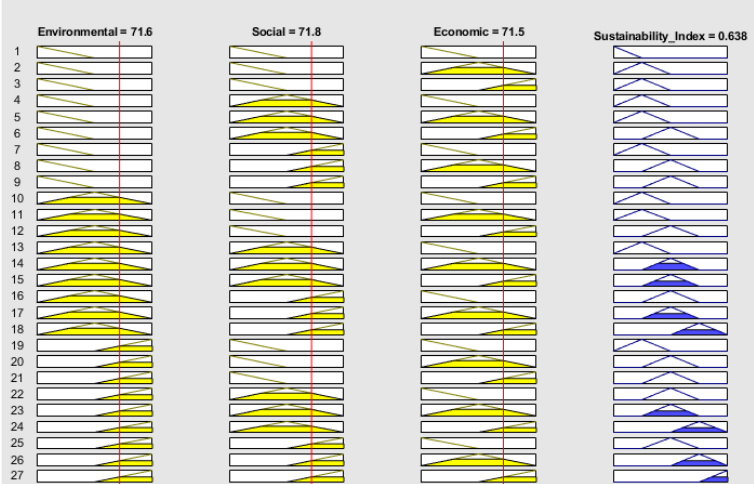
Figure 6. Overall sustainability index of the sample of projects based on the input consensus. Note. Own elaboration.